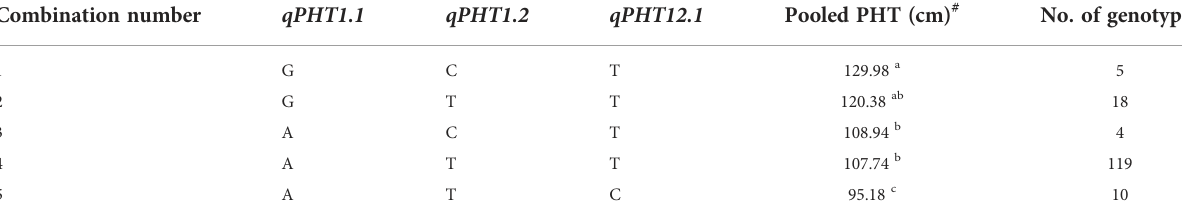
TABLE 8 List of all available homozygous allelic combinations of selected QTNs for PH. Combination number